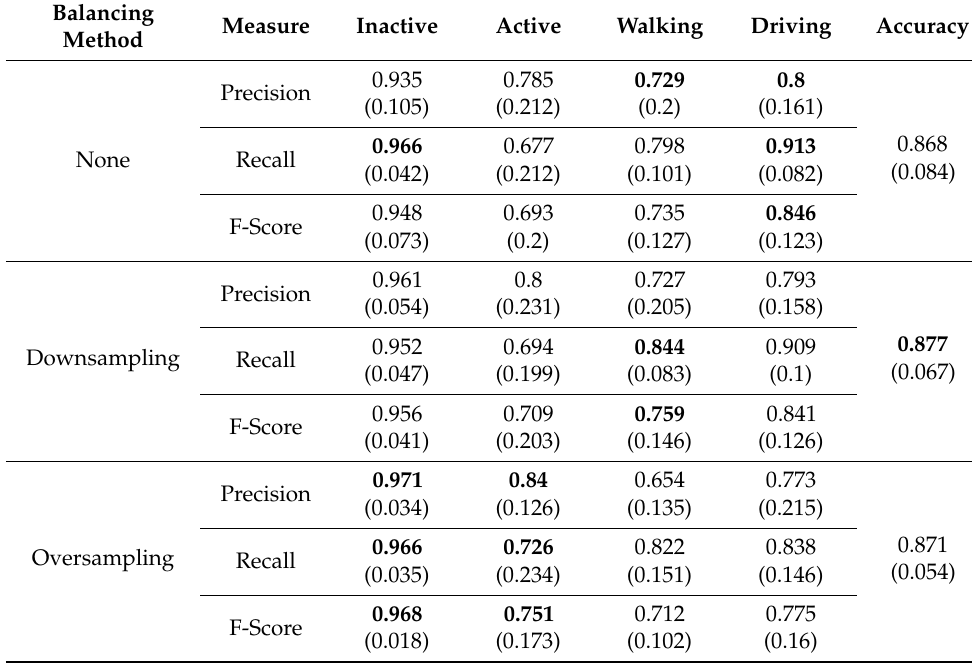
Table 8. Results for trip-wise stratified data.